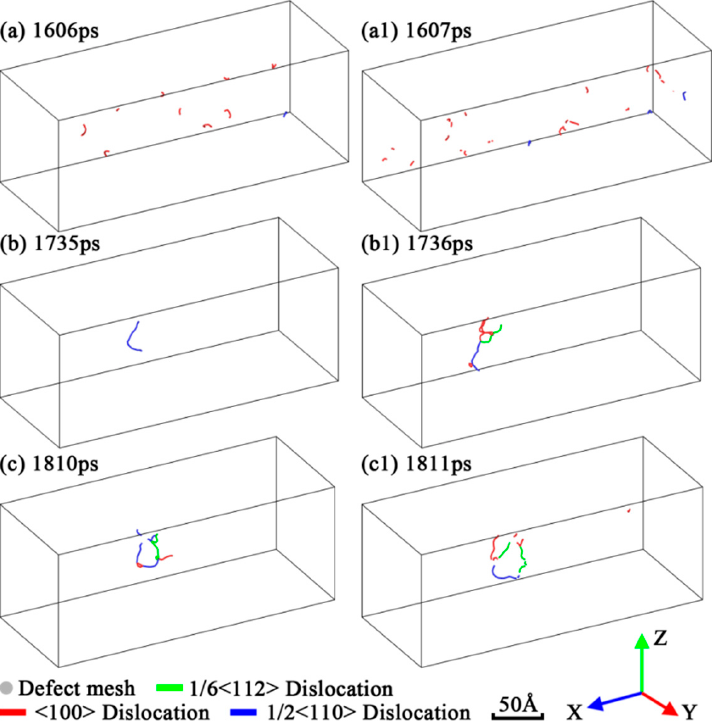
Figure 6. Dislocation and defect mesh in the fracture process of SiNW under three strain rates: ( a ) and ( a1 ) 10 − 2 /ps; ( b ) and ( b1 ) 10 − 4 /ps; ( c ) and ( c1 ) 10 − 6 /ps. The atoms were removed for clarity.